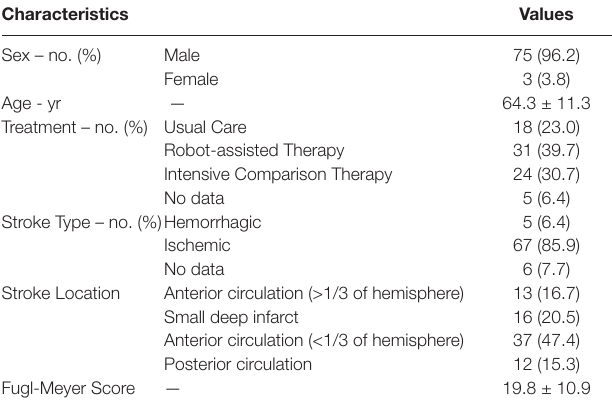
TaBle 1 | Baseline Characteristics of Study Participants. characteristics